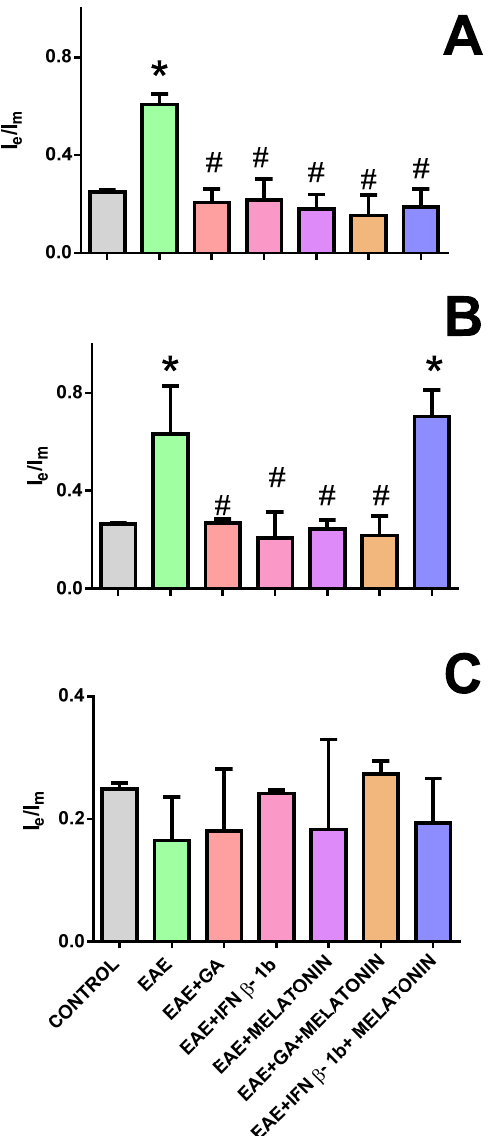
Figure 5. Membrane fluidity in motor cortex ( A ), midbrain ( B ), and spinal cord ( C) homogenates from rats subjected to the indicated treatments. * indicates a significant difference from the control group ( p < 0.05); # indicates a significant difference from the EAE group ( p <